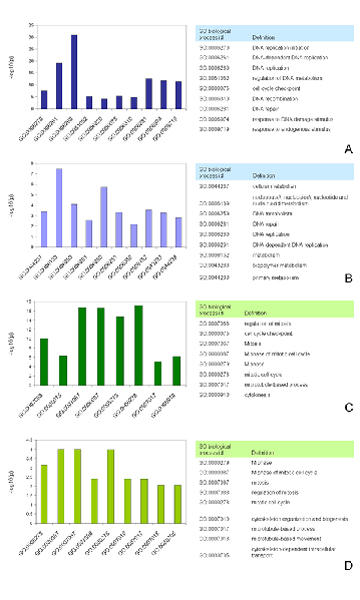
Enrichment in Gene Ontology categories. The x axis of the histogram reports the identifier of the Gene Ontology category, the y axis reports -log10 P, where P represents the significance of the enrichment evaluated by GoTM. (A) Analysis of expanded cluster of genes repressed by pRB, p16, and EWS/FLI using, as reference gene list, NCBI Gene identifiers annotated in the Affymetrix HG_U95Av2 platform. Plotted categories show enrichment greater than 5 fold and occur more than 5 times in the expanded cluster. (B) Analysis of expanded cluster of genes repressed by pRB, p16, and EWS/FLI using as reference gene list the two expanded clusters merged. All the significantly enriched categories are plotted (C) Analysis of expanded cluster of genes induced by pRB, and repressed by EWS/FLI using as reference gene list, NCBI Gene identifiers annotated in Affymetrix HG_U95Av2 platform. Only categories enriched more than 5 fold and occuring more than 5 times are represented. (D) Analysis of expanded cluster of genes induced by pRB, and repressed by EWS/FLI using as reference gene list the merger of the two expanded clusters.